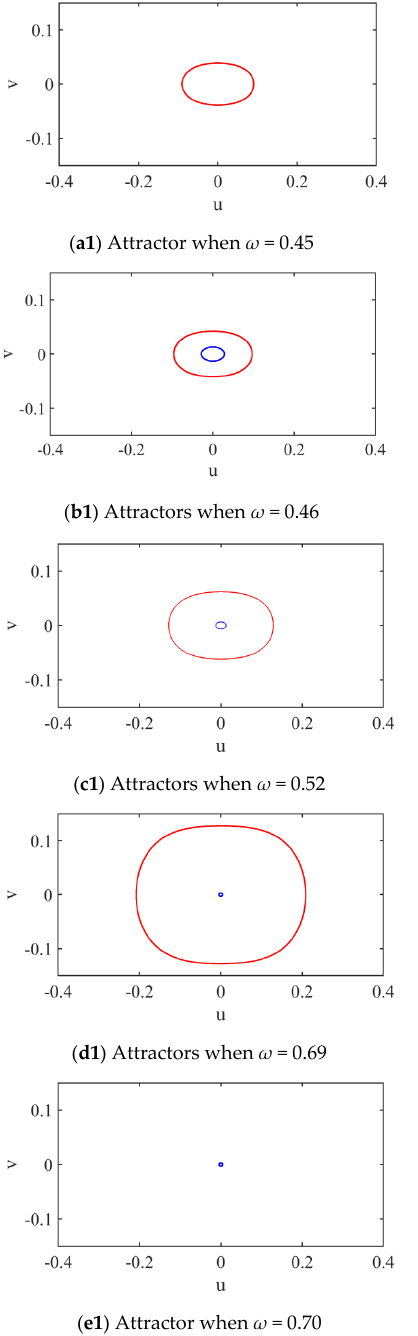
Figure 5. Evolution of multiple attractors and their basins of attraction under different values of ω .